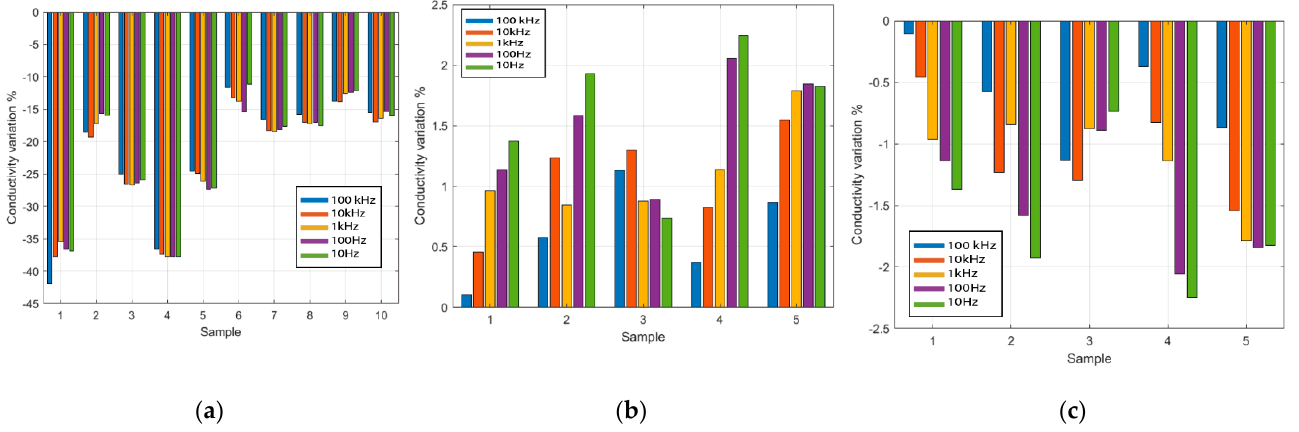
Figure 6. The percentage variation of the conductivity from the proposed experiment at 10 Hz, 100 Hz, 1 kHz, 10 kHz, and 100 kHz. ( a ) Forward experiment with ten LAAs, contact force from 2 N to 10 N ( b ) Reverse experiment with five LAAs, contact force from 10 N to 2 N ( c ) the hyperhydration experiment with five clarified LAAs, contact force from 2 N to 10 N.